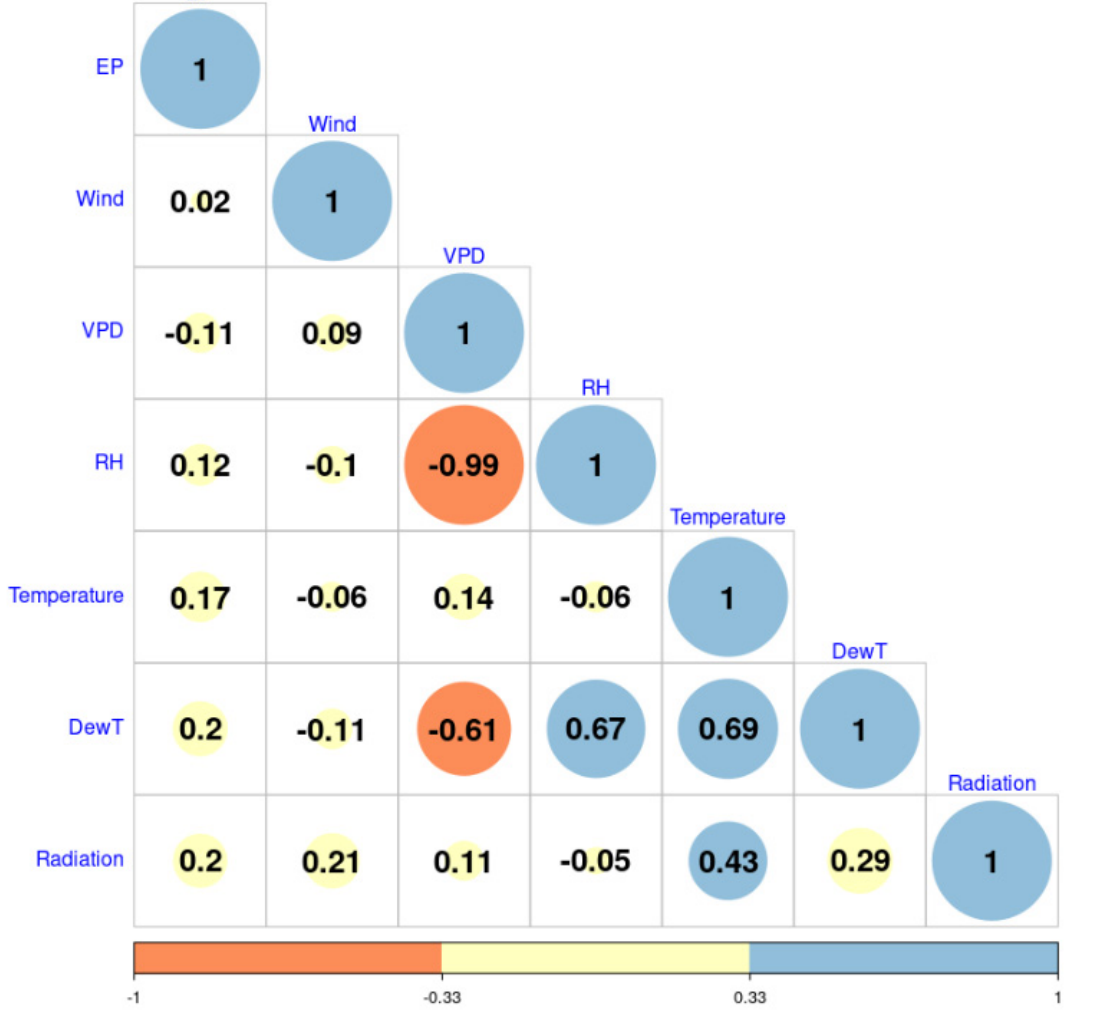
Figure 7. Effective precipitation (EP) versus meteorological variables for the two types of events fog-only and cloud-water, with the corresponding correlation